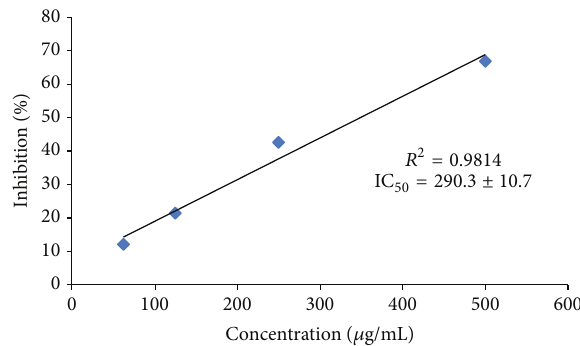
Figure 3: Results from the ABTS test. Values represent mean ± standard deviation of the mean of replicate readings ( 𝑛 = 3 ). The IC 50 values denote the concentration of the sample, which is required to scavenge 50% of free